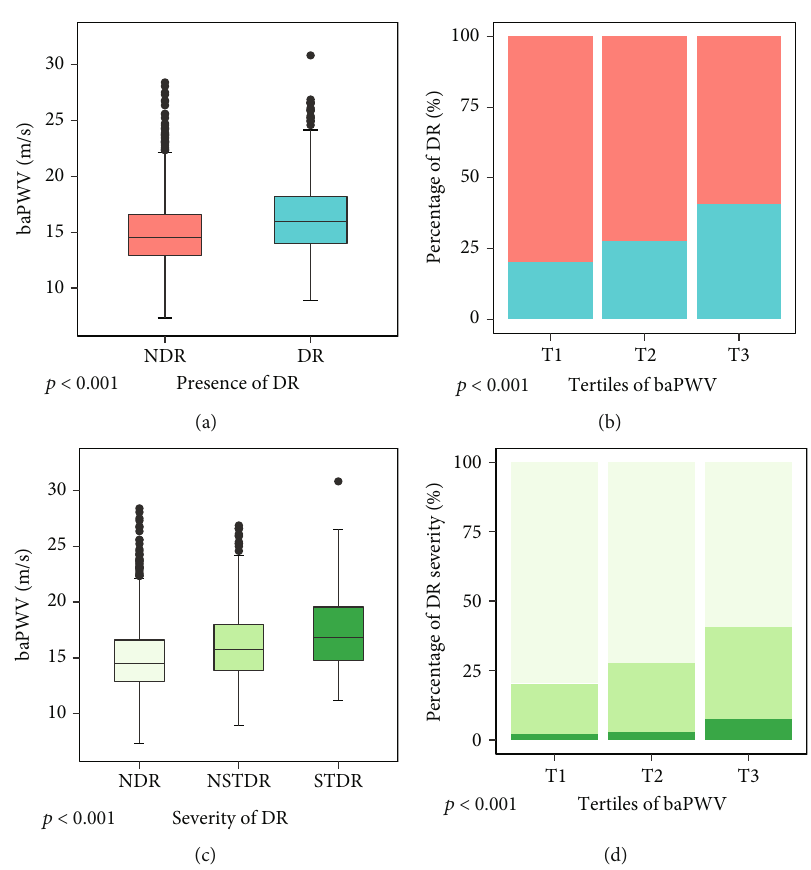
Figure 1: The associations of baPWV with the presence and severity of DR. Di ff erences in baPWV according to the presence of DR (a) and severity of DR (c) were presented by boxplots. Stacked bar plots (b) showing percentages of the presence (bluish-green bar) and absence of DR (orange bar) strati fi ed by tertiles of baPWV, while similar plots (d) displaying di ff erences in the proportions of severe DR (dark green) and mild DR (medium green) among tertiles of